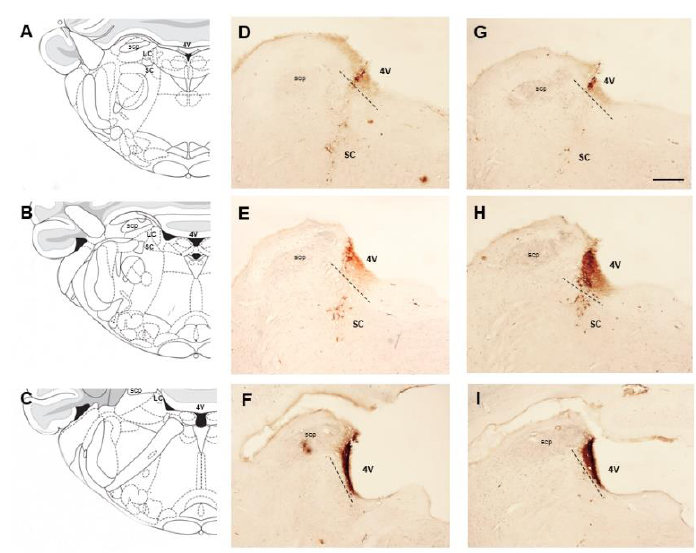
Figure A1. Expression of the TH at the LC. Representative photomicrographs of TH-immunolabelling in animals injected with saline ( D – F ) or kaolin ( G – I ). Each line of images was obtained approximately from the same rostrocaudal level. These levels are better depicted in the diagrams ( A – C ) adapted from the atlas of Paxinos and Watson, namely at 0.30 mm ( A , D , G ), 0.80 mm ( B , E , H ) and 1.30 ( C , F , I ) caudal to the interaural line. The ventricular dilation of the kaolin-injected animals frequently leads to some distortion of the 4th ventricle (4V). Additional landmarks were added, namely the superior cerebellar pedunculus (scp) and the subcoreular area (SC). In this study, the analysis was only performed at the LC area, located above the dashed lines. The differences in TH expression between the 2 experimental groups are better depicted in intermediate ( − 0.80 mm) and caudal ( − 1.30 mm), although we did not quantify in detail the density of TH-immunostaining in each rostrocaudal level. The images of the intermediate levels ( − 0.80 mm) are the same as Figure 2 to allow to infer the density of LC neurons at the dorsal part of the LC. Scale bar in A corresponds to 1 mm and all the photomicrographs are at the same magnification.